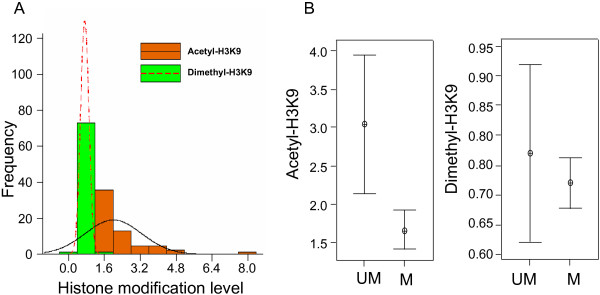
Histone modifications and DNA methylation status in mouse promoter regions. A. Histogram of histone acetylation and dimethylation identified by ChIP-chip with mouse custom promoter array. Brown and green bars indicate the frequency of acetyl-H3K9 and dimethyl-H3K9. Frequency curves are shown as follows: continuous line, acetyl-H3K9; dash line, dimethyl-H3K9. B. Interval plots of histone modifications versus DNA methylation. Histone modifications were plotted with two groups: unmethylated and methylated genes identified by RLGS. The interval bars indicate the distribution of histone modifications with horizontal lines at the endpoints of the 95% confidence interval for the mean and a symbol at the mean.